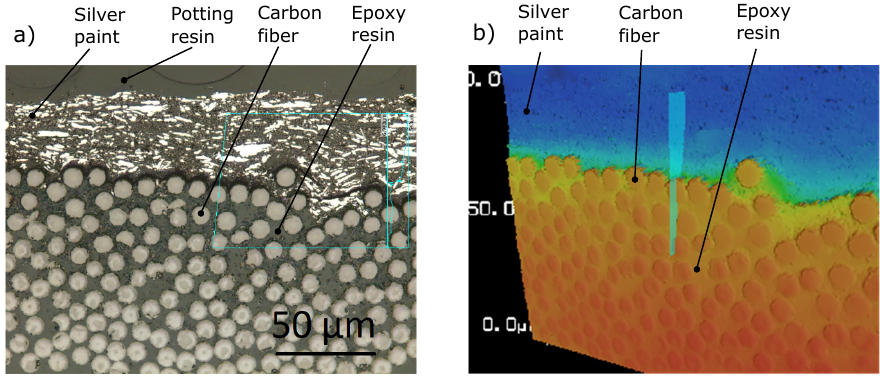
Figure 10. Microscopy study of an electrical contact manufactured with silver paint showing ( a ) a microscopic image and ( b ) an image from a laser scanning microscope showing the height profile.